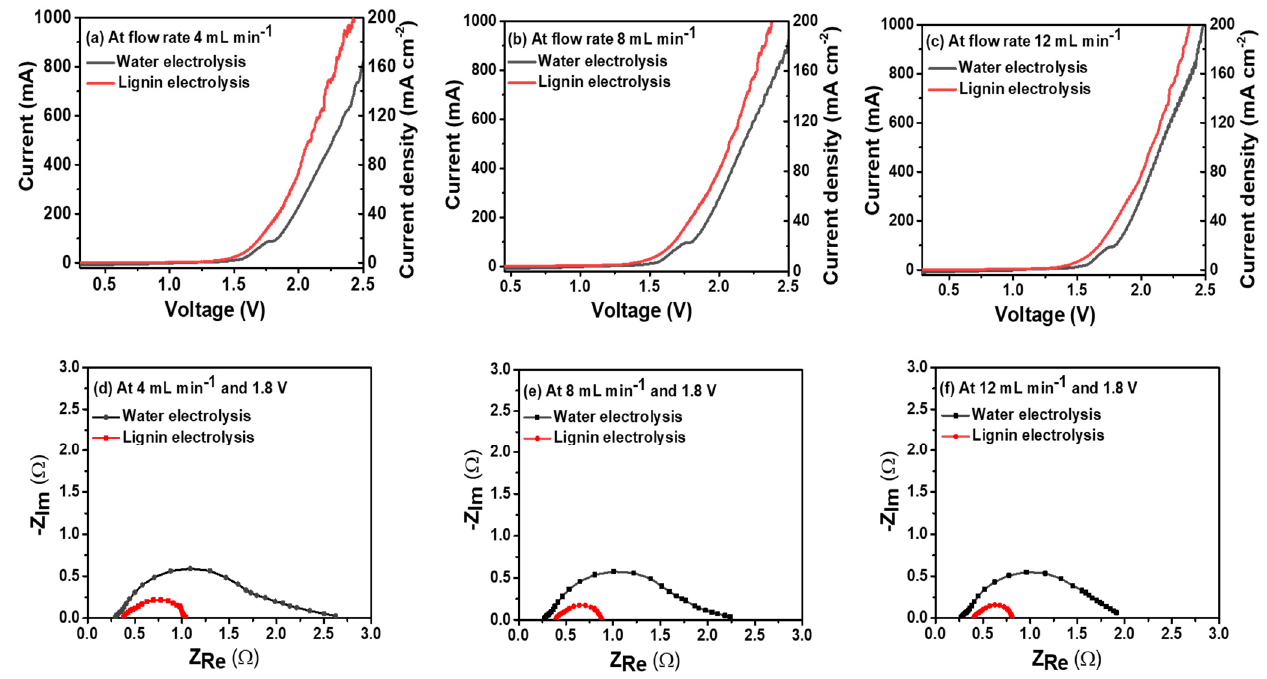
Figure 2. Linear sweep voltammograms (LSVs) comparing the difference in overvoltage and current density between water electrolysis and lignin electrolysis at ( a ) 4 mL min − 1 , ( b ) 8 mL min − 1 , and ( c ) 12 mL min − 1 . The electrochemical impedance spectroscopy (PEIS) at 1.8 V comparing the ohmic and charge transfer resistance between the water electrolysis and lignin electrolysis at ( d ) 4 mL min − 1 , ( e ) 8 mL min − 1 , and ( f ) 12 mL min − 1 .